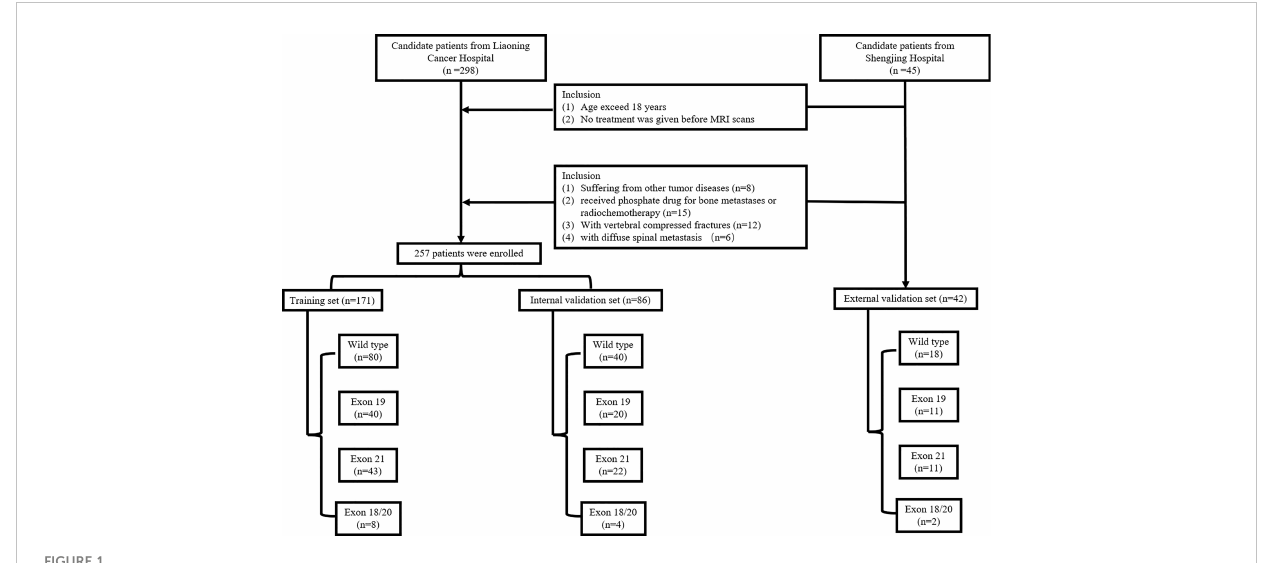
FIGURE 1 The patient selection and work fl